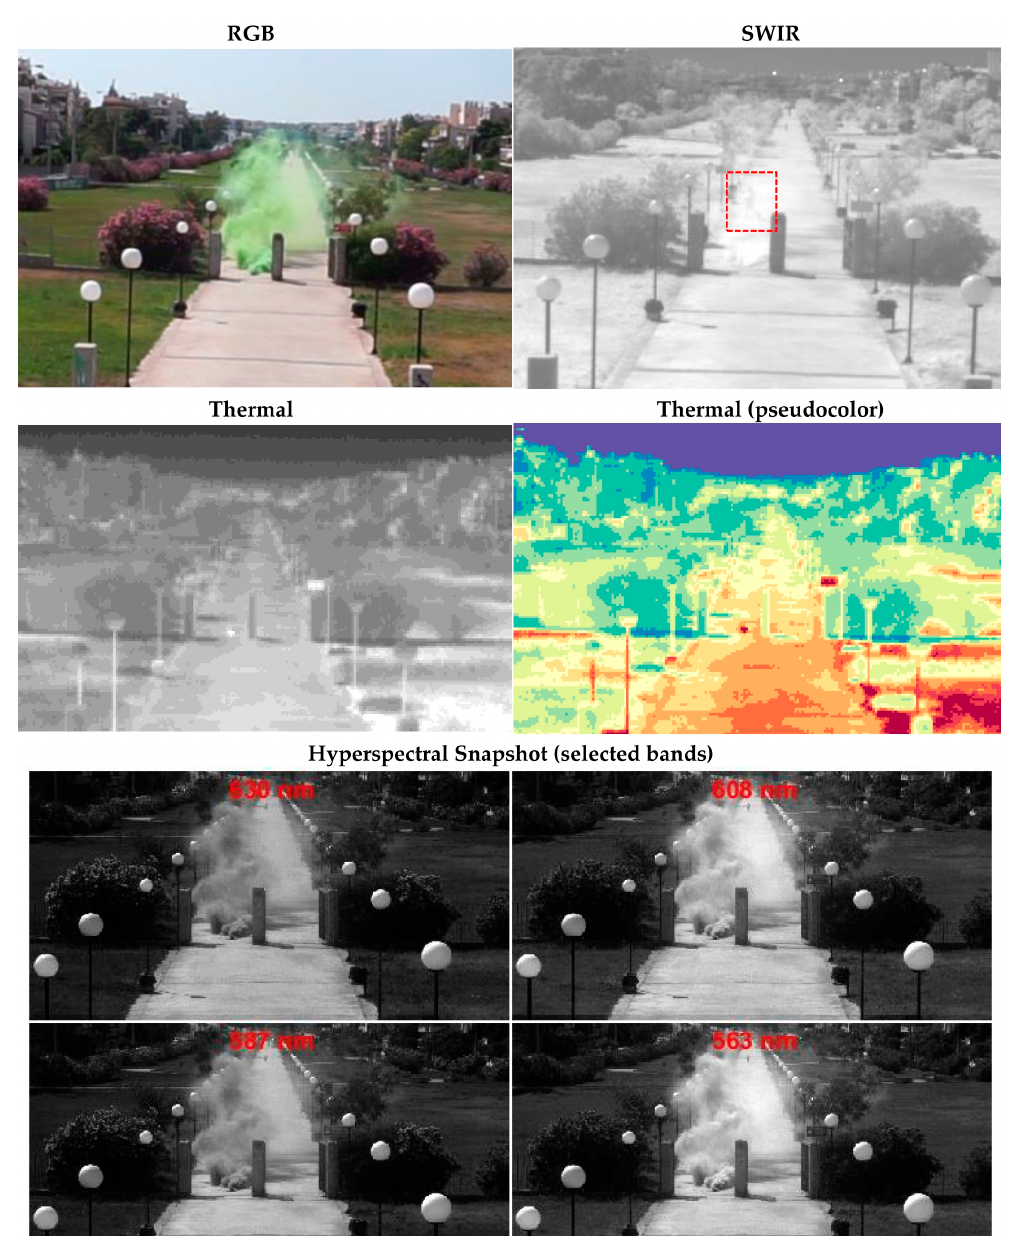
Figure 1. In challenging indoor or outdoor environments with dynamically changing conditions like different smoke, fog, humidity, etc., levels, the standard moving object detection and tracking algorithms fail to detect moving targets based on just a single imaging (usually RGB CCTV) source.